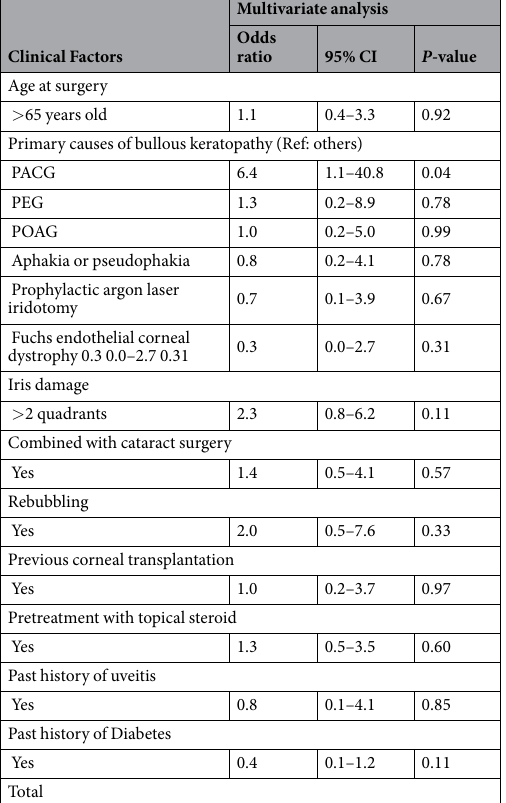
Table 2. Predictive clinical factors in patients with cystoid macular edema. CME: cystoid macular edema, CI: confidence interval, PACG: primary angle-closure glaucoma, PEG: pseudoexfoliation glaucoma, POAG: primary open-angle